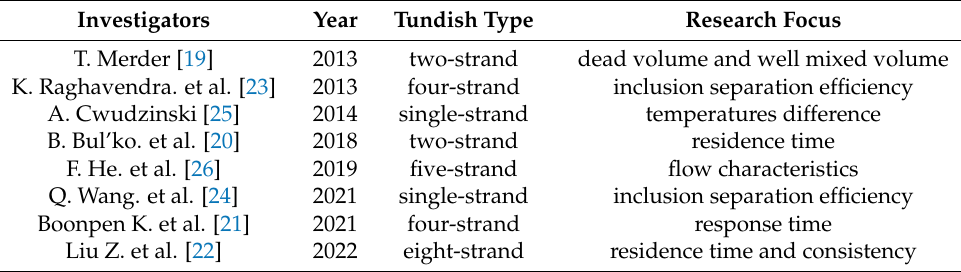
Table 1. Research on effect of tundish casting speed